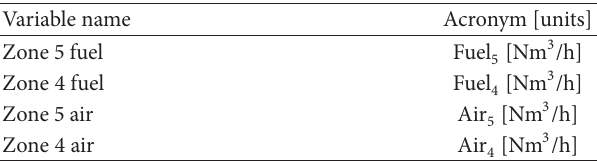
Table 7: Considered set of MVs. Table 8: Considered set of CVs/rCVs.